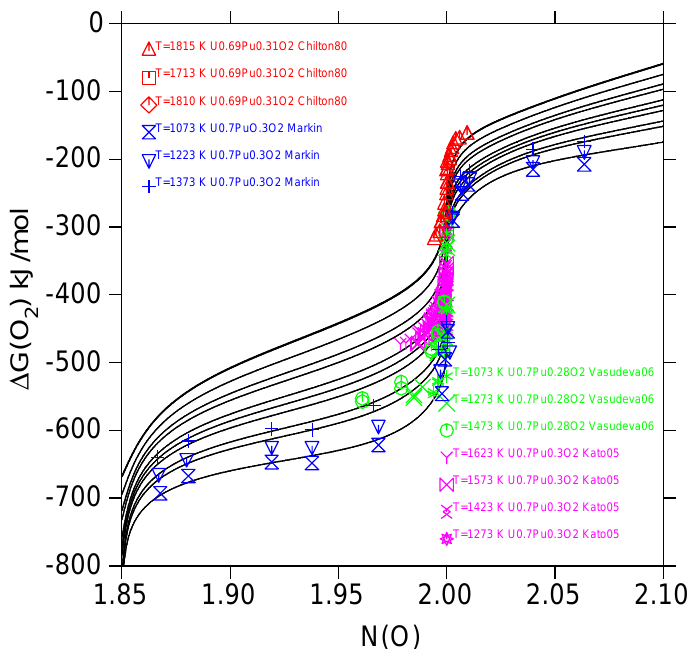
Fig. 3 : Oxygen chemical potentials at different temperatures and varying oxygen content for systems with Pu/u ratios around 0.3, together with experimantal